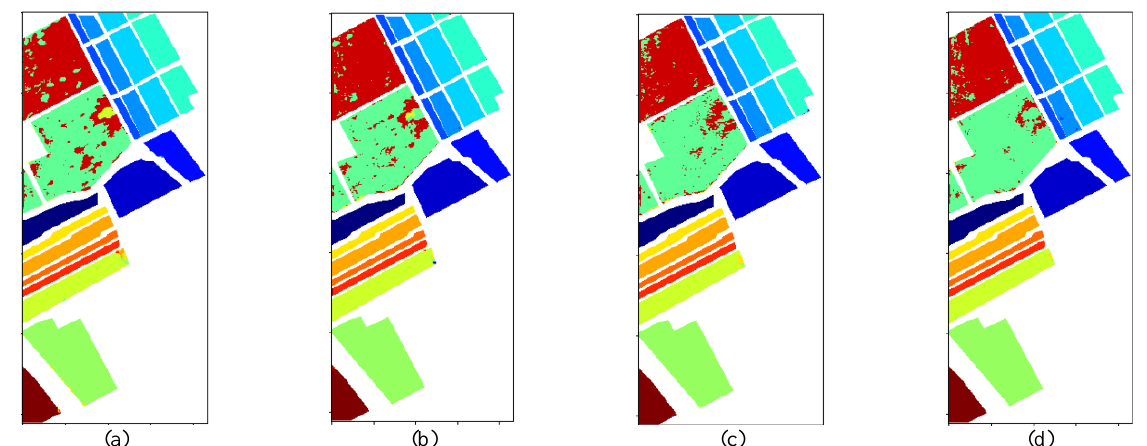
Figure 6. Classification results of Salinas with 7×7 input patch with 2 convolutional layers and 2 fully-connected layers trained with